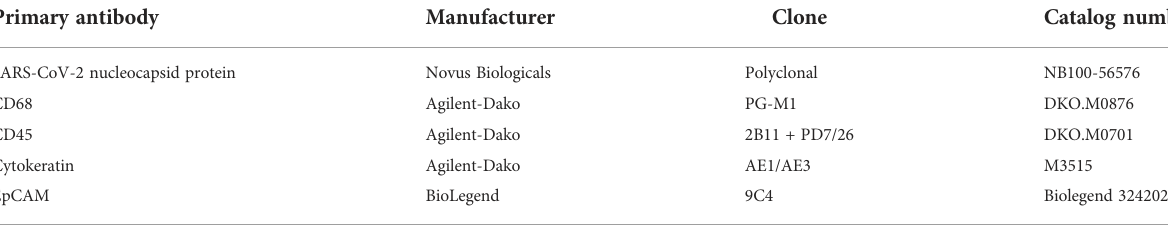
TABLE 2 Antibodies used for multiplex immunohistochemistry. Primary